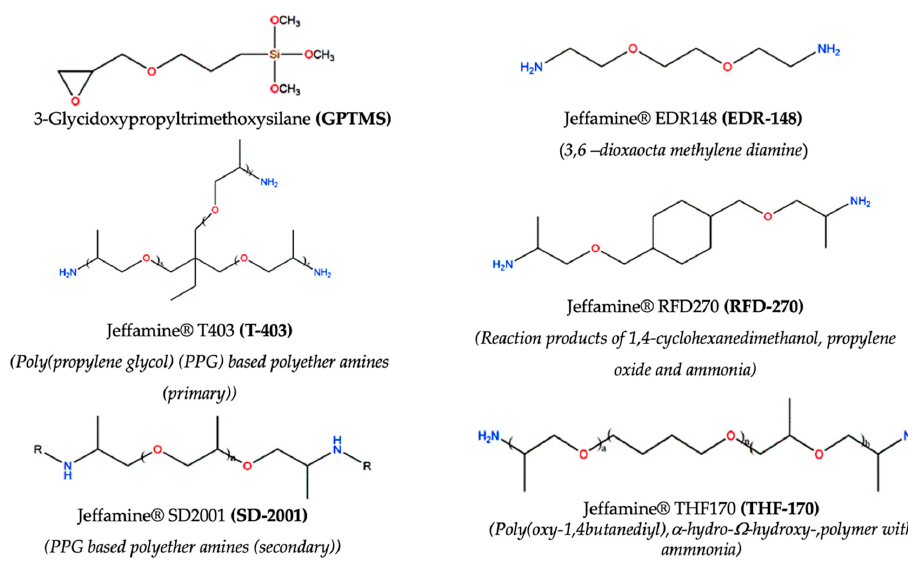
Figure1. Structureandacronym(inbold)oftheprecursorsusedinthesynthesisoftheorganic–inorganic Figure 1. Structure and acronym (in bold) of the precursors used in the synthesis of the organic– hybrid sol-gel inorganic hybrid sol-gel materials.